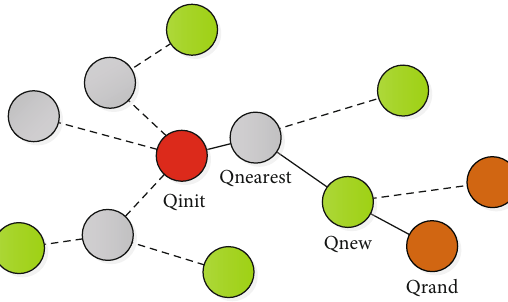
Figure 3: Expansion diagram of the RRT ∗ algorithm.